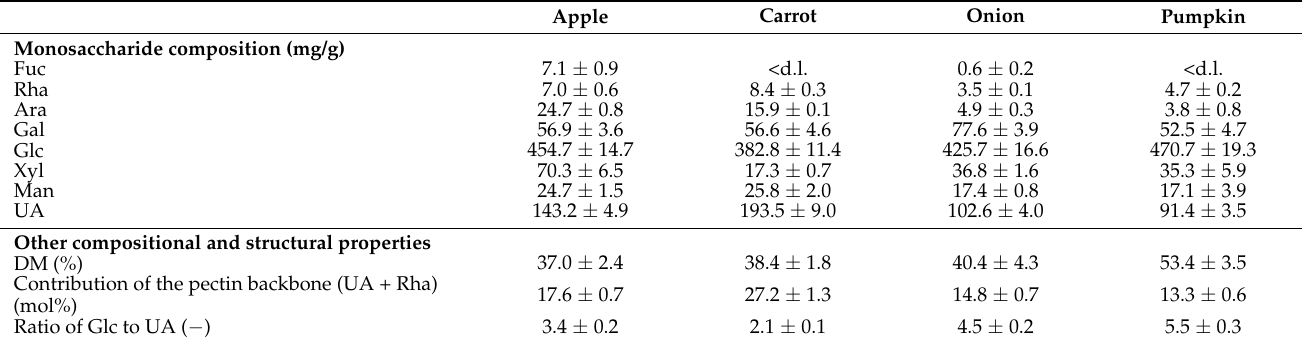
Table 1. Monosaccharide content (mg/g), the degree of methyl esterification (DM) (%), the contribution of the pectin backbone (mol%) and ratio of Glc to UA ( − ) of the acid-unextractable fractions of the different matrices ± standard deviation ( n = 2 × 2); <d.l. = below detection limit. Apple Carrot Onion Pumpkin Monosaccharide composition (mg/g) Fuc 7.1 ±